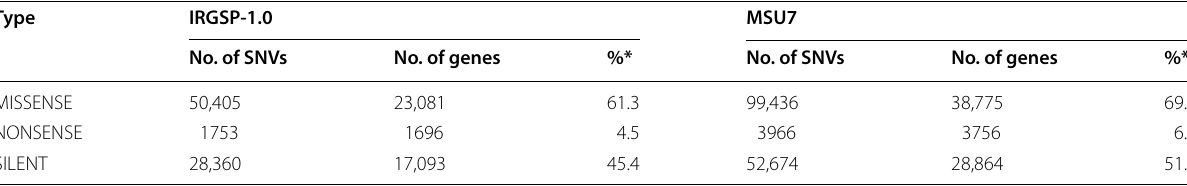
*% Represents the proportion of genes containing one or more SNVs for each mutation type to the total annotated genes (IRGSP-1.0, 37,662 genes; MSU7, 55,718 genes)